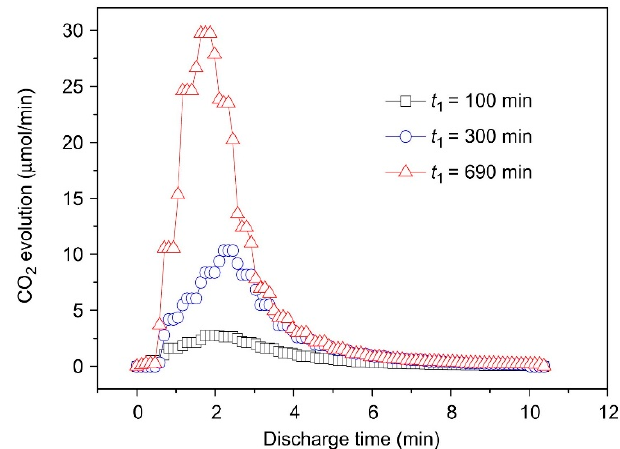
Figure 26. CO 2 evolution with discharge time in cyclic APC of HCHO over AgCu/HZ at various storage periods (100, 300 and 690 min) (storage stage: simulated air at 300 mL/min, 50% RH; discharge stage: O 2 at 6 mL/min, P APC = 2.3 W). Reprinted from reference [44], with permission from Elsevier.